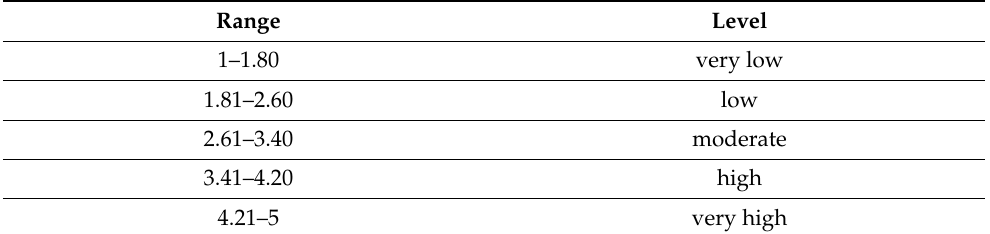
Table 2. Level lookup table of values and ranges.